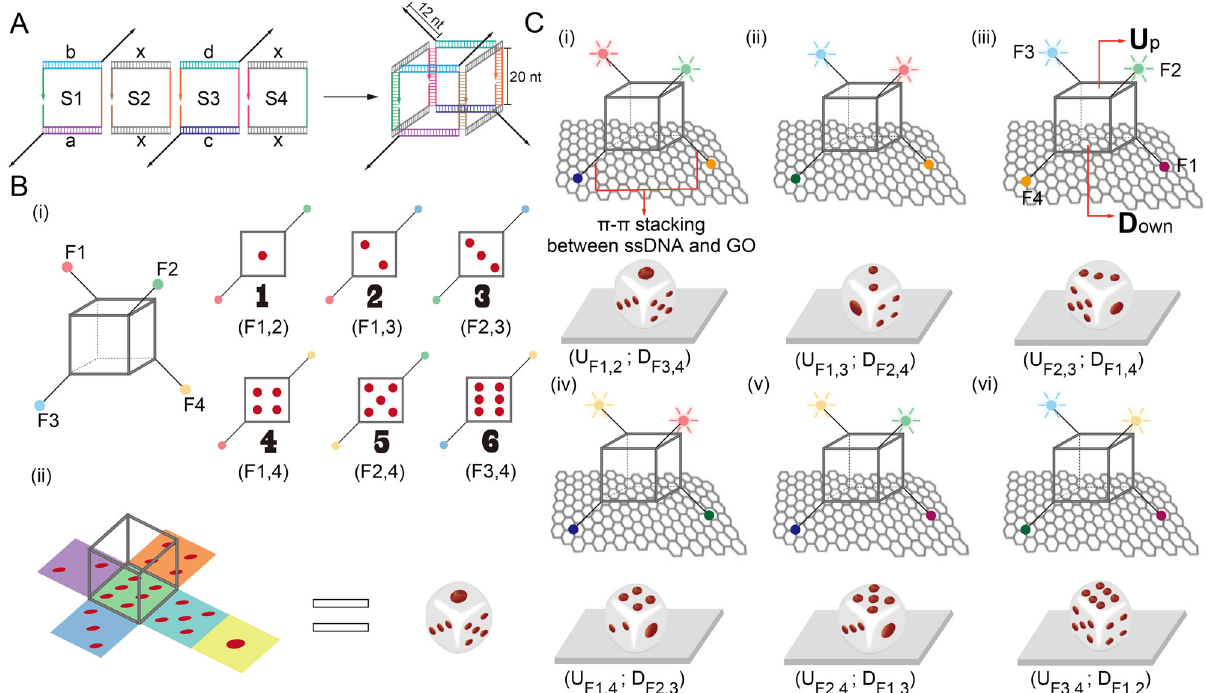
Fig. 1 | Design of DNA cube-based system for mimicking dice throwing. A SchematicillustrationofDNAcube. B DicesimulationatthenanoscaleusingDNA cube with FAM-labeled t-DNA at four symmetrical corners. C The design of DNA